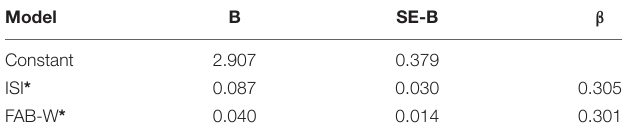
Fear-avoidance beliefs questionnaire-work subscale; ISI, Insomnia severity index.